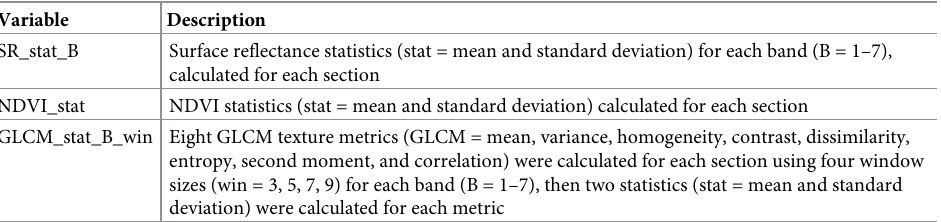
Table 2. Satellite-derived